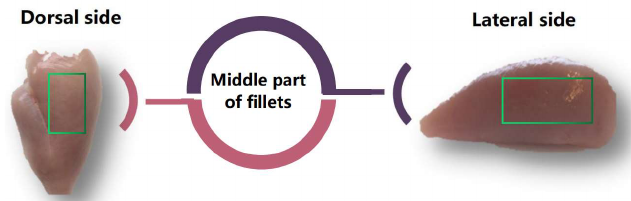
Figure 1. Sampling position diagram.